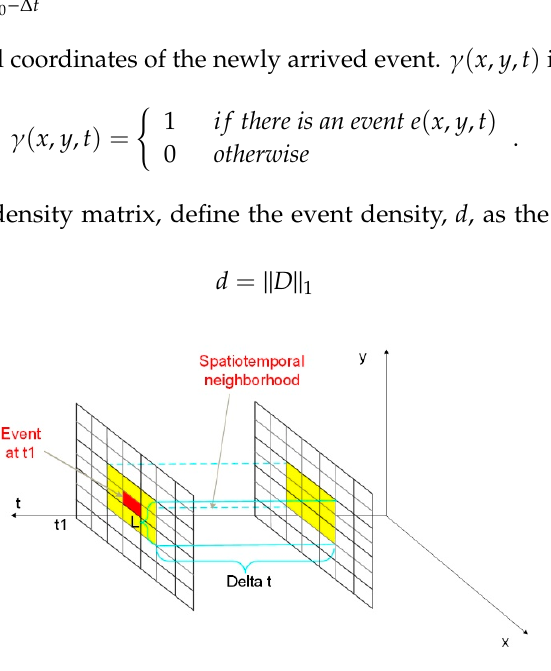
Figure 2. Schematic of the spatiotemporal neighborhood. The red-point indicates a newly arrived event at t 1, the surrounding yellow part indicates the spatial neighborhood of the new-arrival event, and delta, t, which is the time period before t 1 is the time neighborhood of the event. The time neighborhood and spatial neighborhood form a spatiotemporal